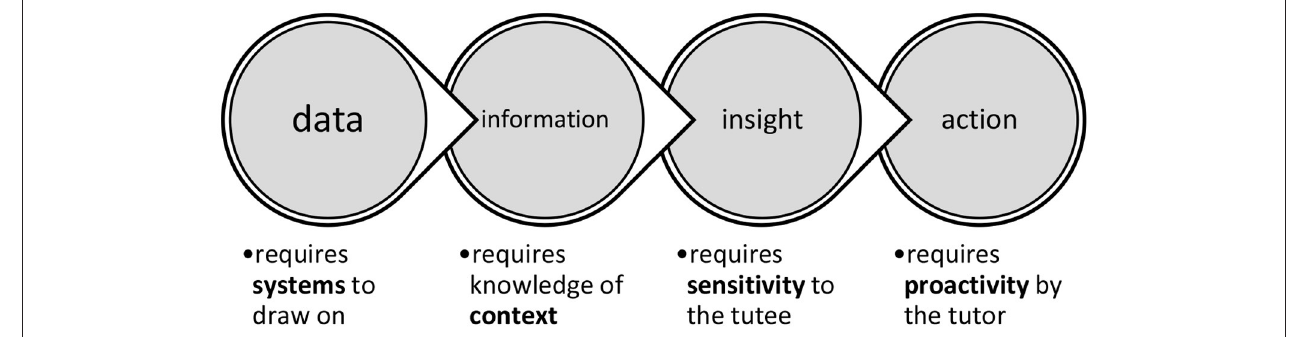
FIGURE 1 | Moving along the value